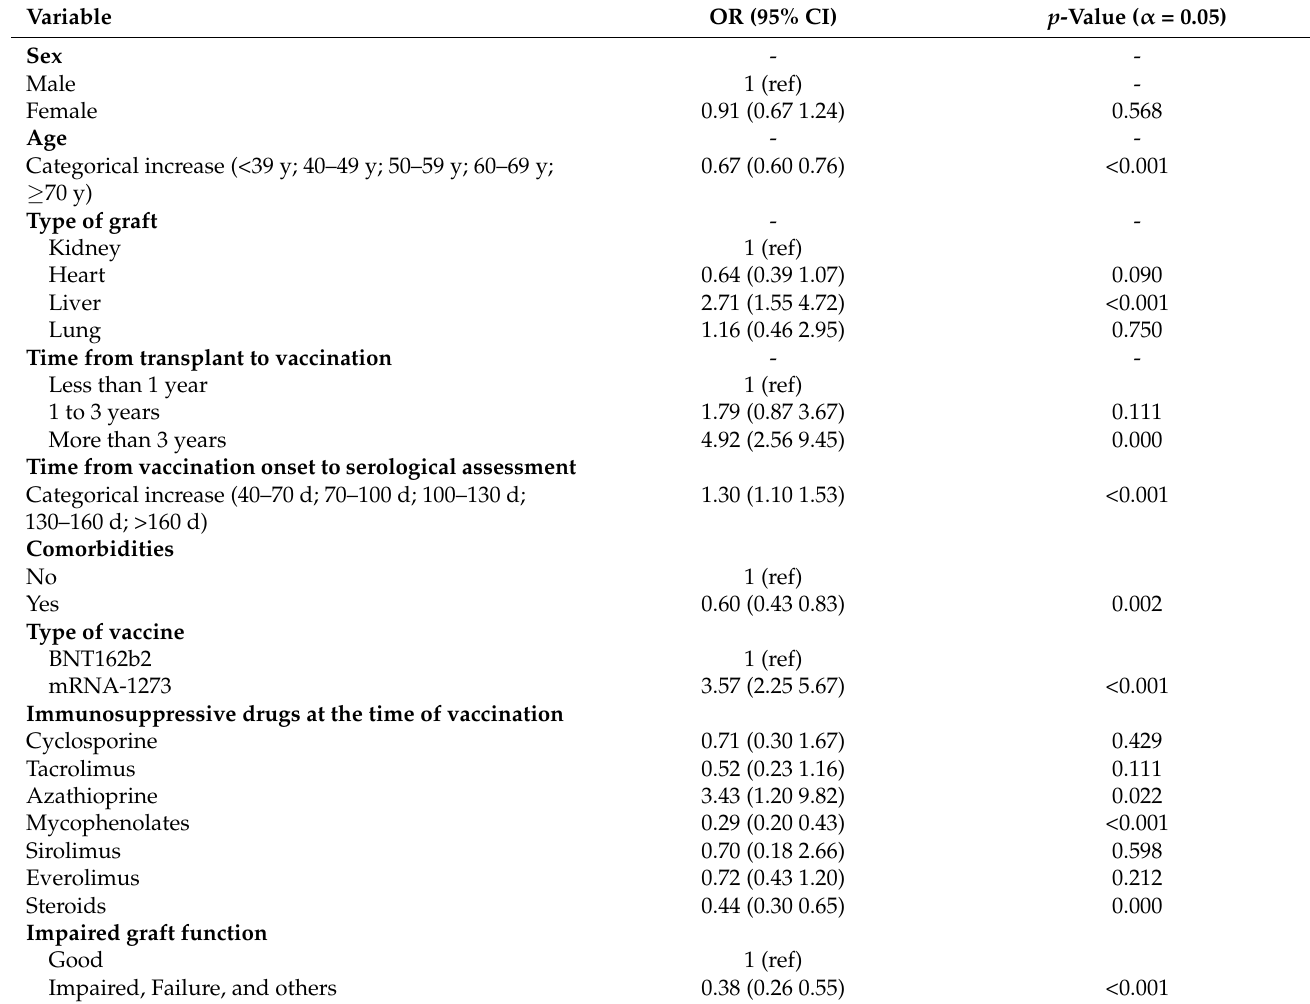
Table 2. Multivariable analysis of predictors of antibody response at 3 ± 1 months after first dose administration of mRNA COVID-19 vaccine in SOT